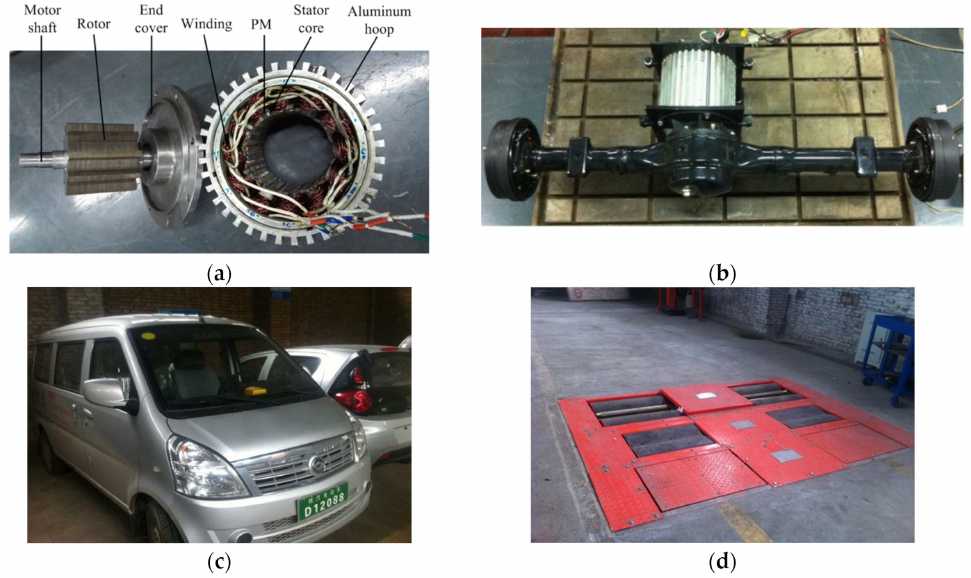
Figure 6. Experimental setup. ( a ) Prototype of FSPM; ( b ) drivetrain with FSPM motor; ( c ) CEV with FSPM motor; ( d ) experimental bench for vehicles.